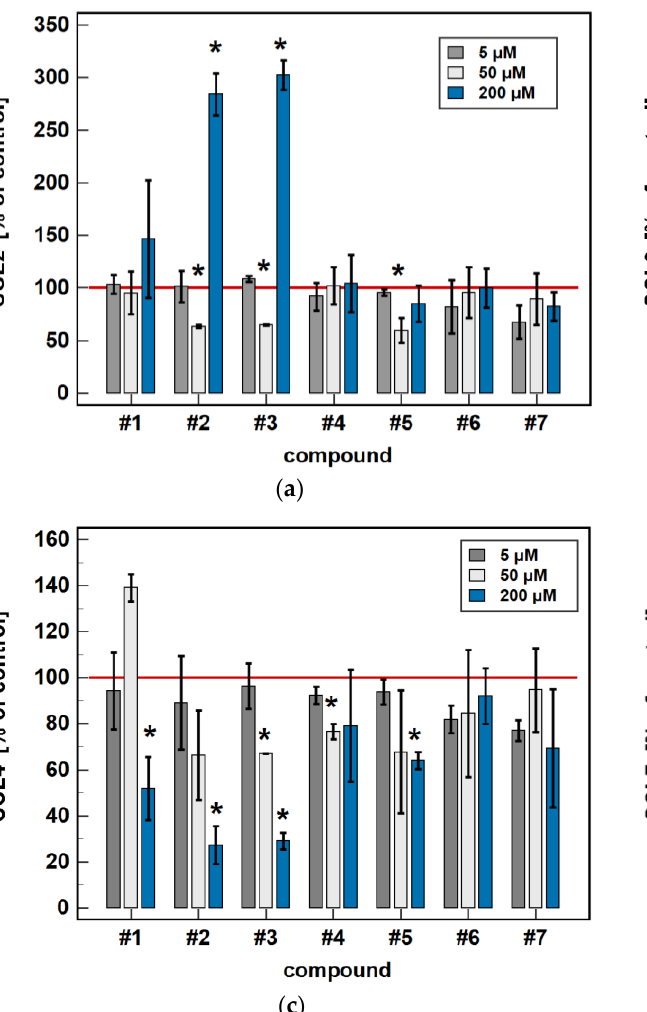
Figure 8. Dose-dependent effect of oxicams’ MCP and MIP secretion in Caco-2 cells: ( a ) MCP-1/CCL2; ( b ) MIP-1 α /CCL3; ( c ) MIP-1 β /CCL4; ( d ) MCP-3/CCL7. The bars represent the mean ± SD (whiskers) ratio of the chemokine concentration in the medium from cells treated with 5, 50 and 200 µ M oxicams for 24 h, as compared to untreated controls, expressed as a percentage. The significant differences between the secretion from treated and untreated cells, analyzed using a t -test for one mean, are indicated by asterisks (*). The reference secretion of the control cells is indicated by a red solid line. Compound # 6 denotes piroxicam, and # 7 denotes meloxicam.